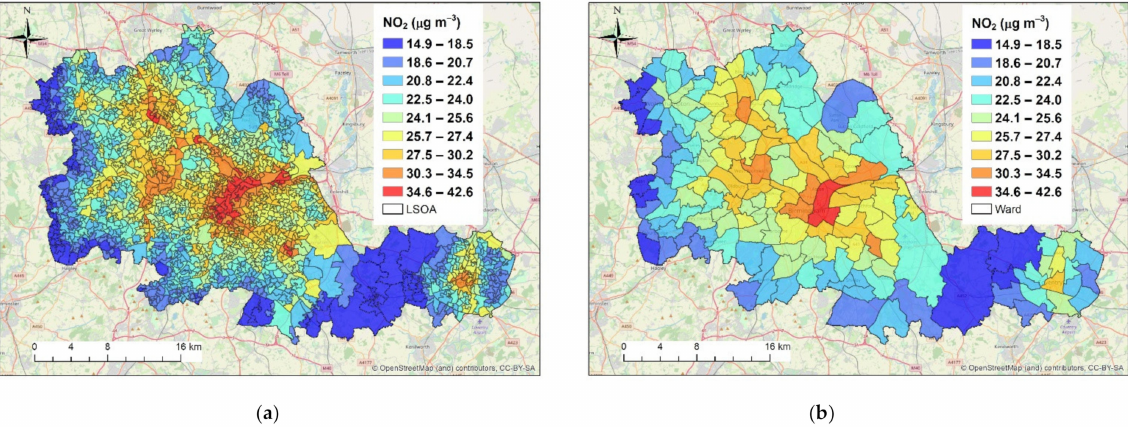
Figure 8. Projected annual air quality maps for NO 2 (in µ g m − 3 ) ( a ) in the Lower Layer Super Output Areas (LSOA) layer and ( b ) in the ward level.